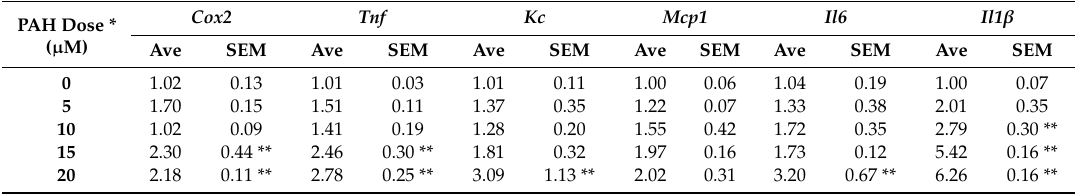
Table 1. MHS cell inflammatory cytokines / chemokine response following 4 h treatment with the binary PAH mixture.